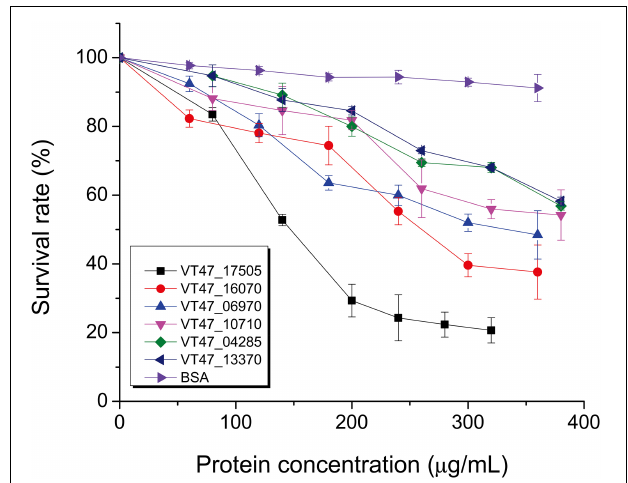
FIGURE 4 | Nematicidal activity of purified bacterial proteins. Potential nematicidal proteins of P. syringae MB03 were expressed in E. coli TOP10 or JM109 and purified by affinity column chromatography for the liquid killing assay. The killing of worms was determined after 3 days. Worms that did not respond to the touch were considered dead. Bovine serum albumin (BSA) was used as a control. The experiment was performed in triplicate and mean values are represented. On X -axis, concentrations of purified proteins are shown. On Y -axis, survival of C. elegans is shown. NCBI accession numbers of the genes are shown in text box (VT47_17505 esterase, VT47_16070 undefined protein, VT47_06970 membrane protein, VT47_10710 chitinase, VT47_04285 MCP, VT47_13370 MCP). The details and selection criteria of these proteins are provided in Table 6